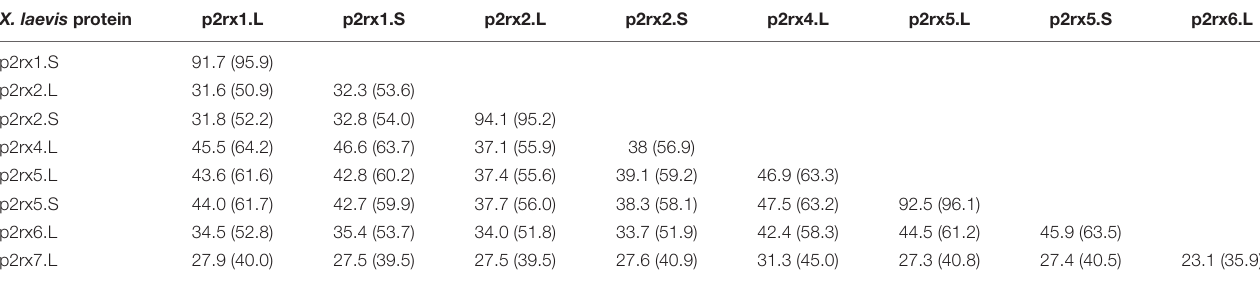
TABLE 1A | Relatedness of the X. laevis p2x receptor subunits.